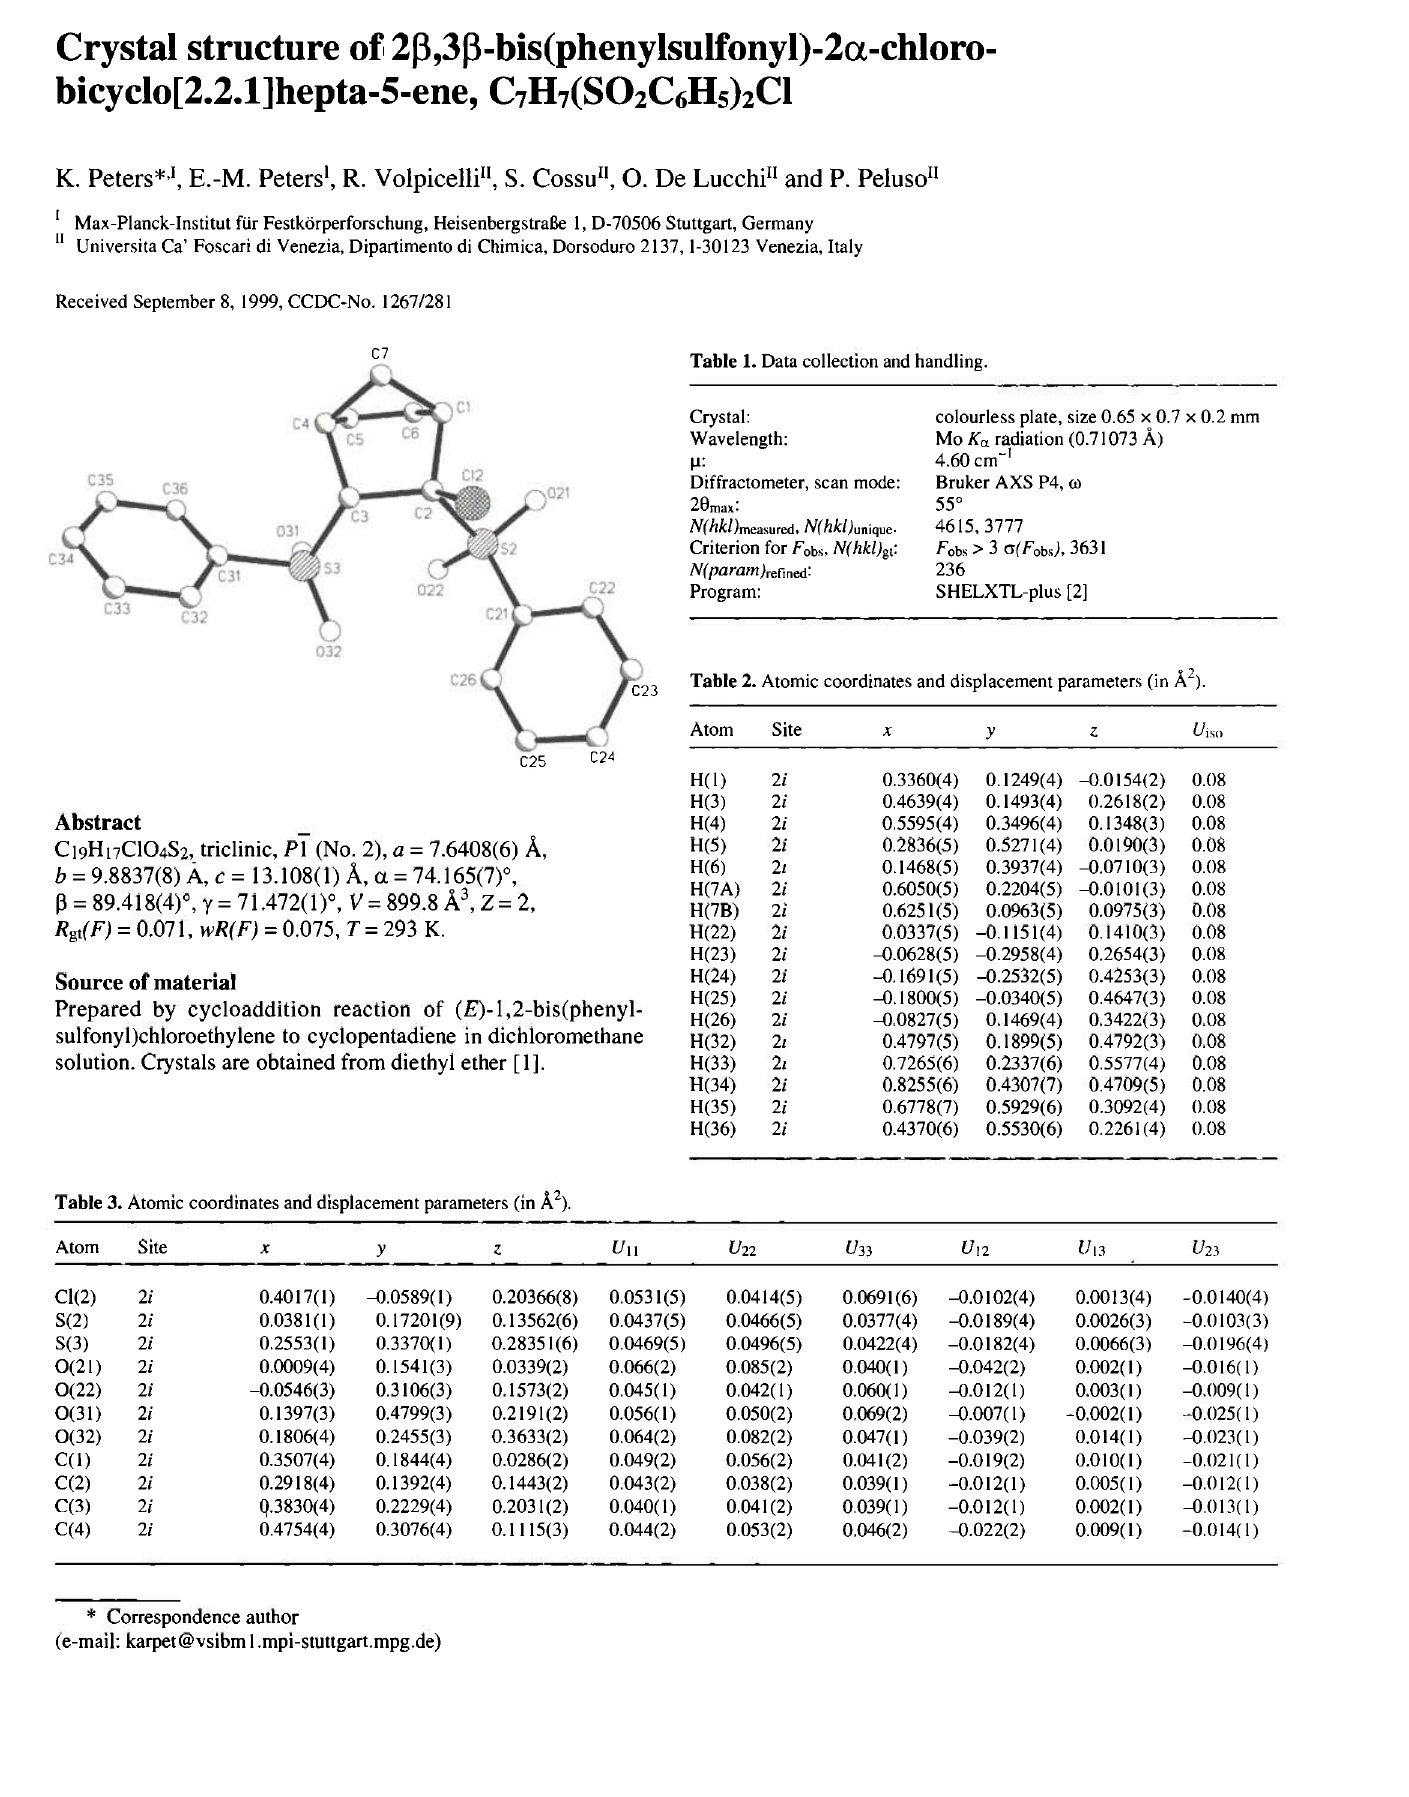
Table 3. Atomic coordinates and displacement parameters (in Ä 2 ).